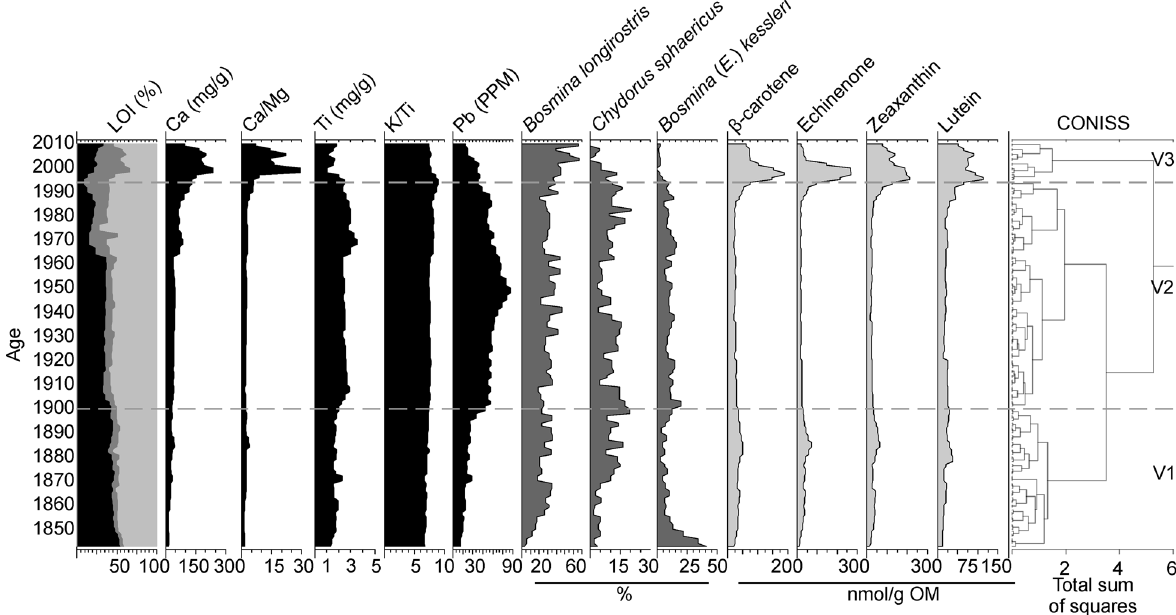
Fig. 5. Selected variables from the sediment of Lake Verevi in age scale and results of CONISS analysis of all data (84 variables). Loss on ignition (LOI 550 and 950) data are marked as follows: black – organic matter; dark grey – CaCO 3 ; light grey – siliciclastic mineral